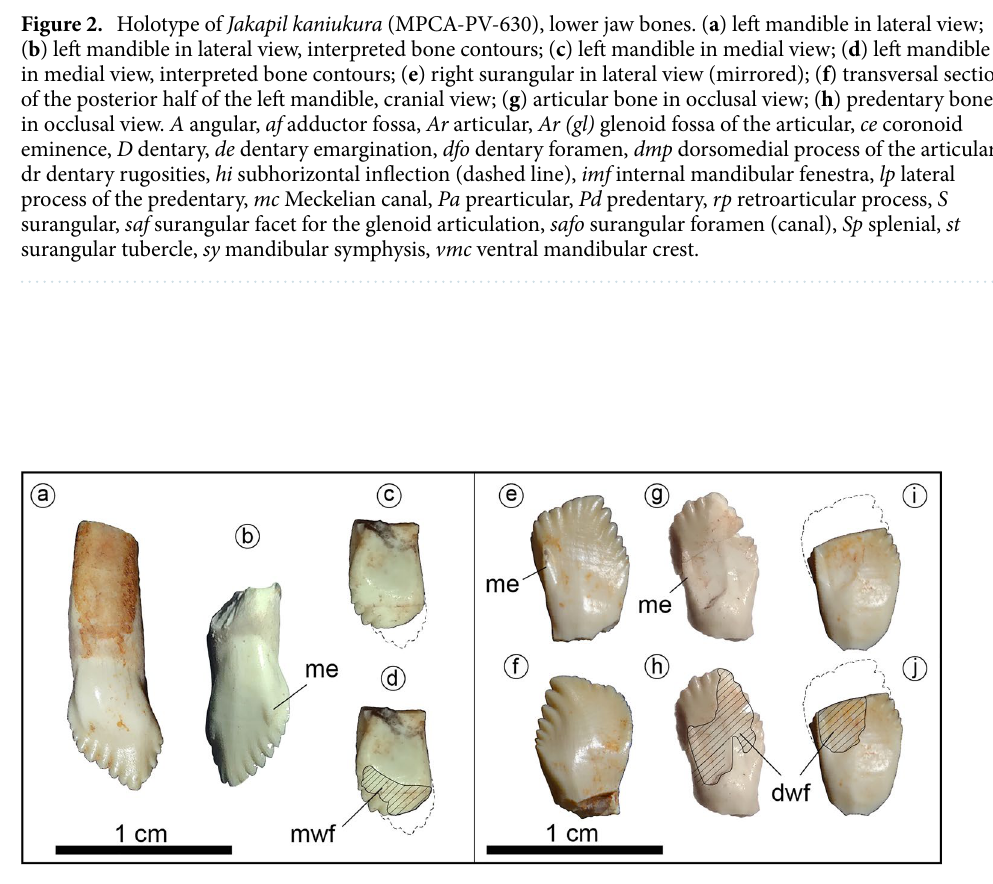
Figure 3. Holotype of Jakapil kaniukura (MPCA-PV-630), teeth. Maxillary teeth in labial ( a , b ) and lingual ( c , d ); ( d ) highlight the wear facet) views; dentary teeth in lingual ( e , g – j) ; ( h,j ) highlight the wear facets) and labial ( f ) views. dwf dentary tooth wear facet, me prominent mesial edge, mwf maxillary tooth wear